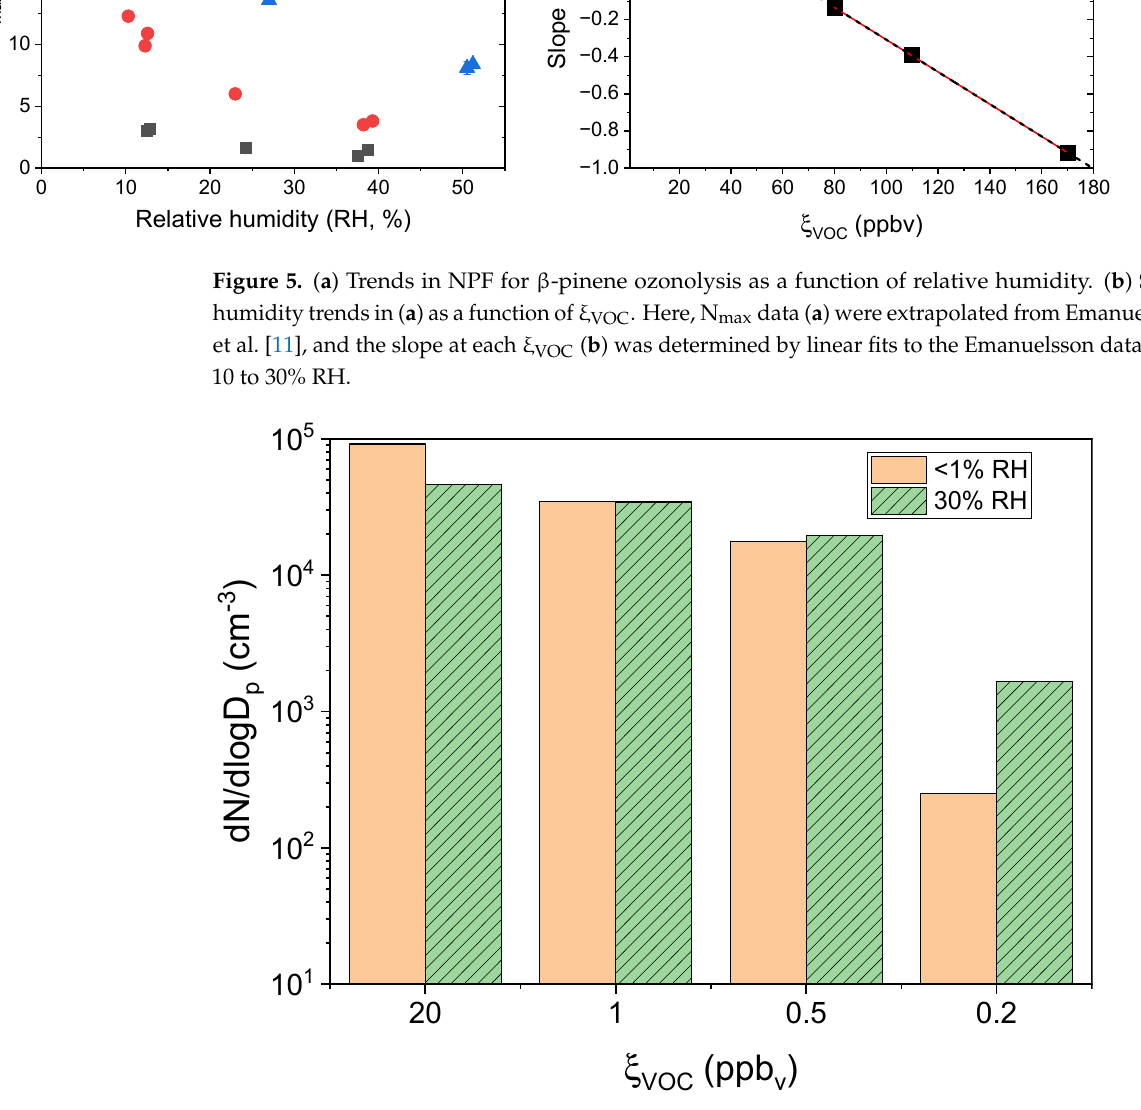
Figure 6. NPF from dark ozonolysis of β -pinene at two levels of RH and as a function of ξ VOC . ξ O3 = 500 (±10) ppb v .